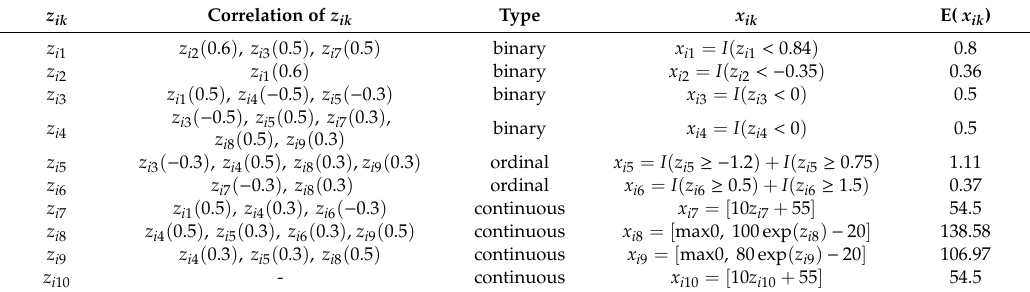
Table 1. Covariate structure applied in the simulation study. I ( · ) is the indicator function that equals 1 if the argument is true, and 0 otherwise. [ · ] indicates that a non-integer part of the argument is